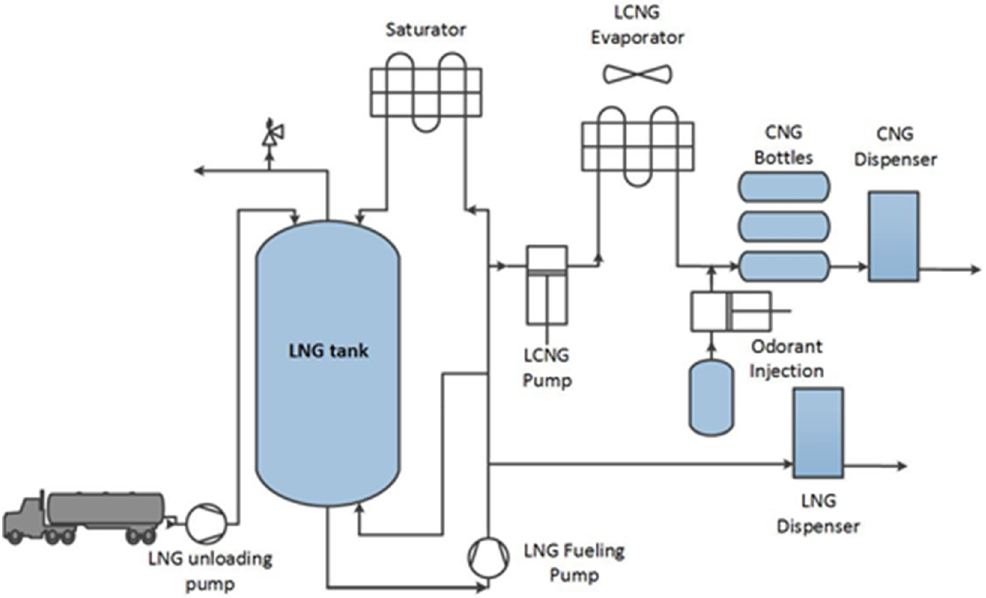
Figure 3. Schematics of typical LNG/CNG (compressed natural gas) filling station [71].